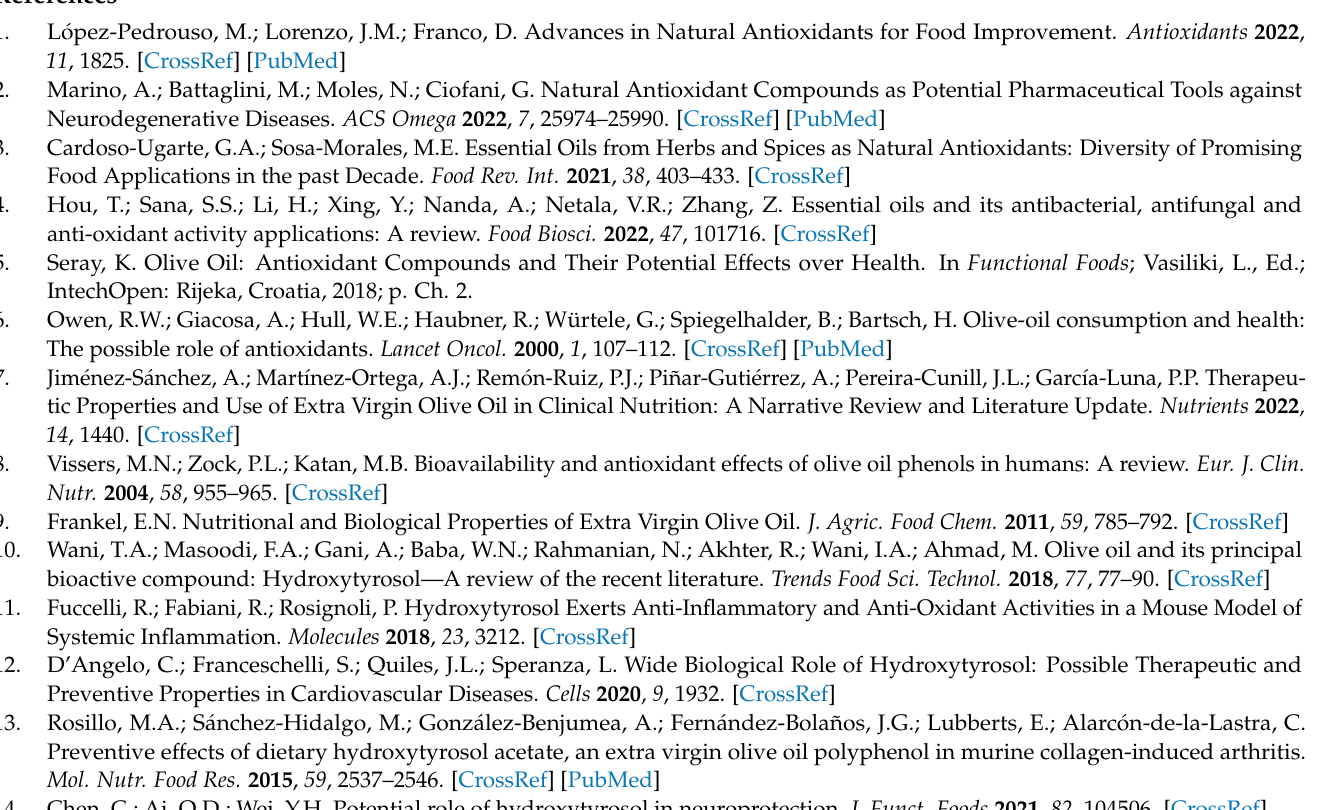
Table S1: Phenolic profile of virgin olive oil (VOO) extracted from Koroneiki olive